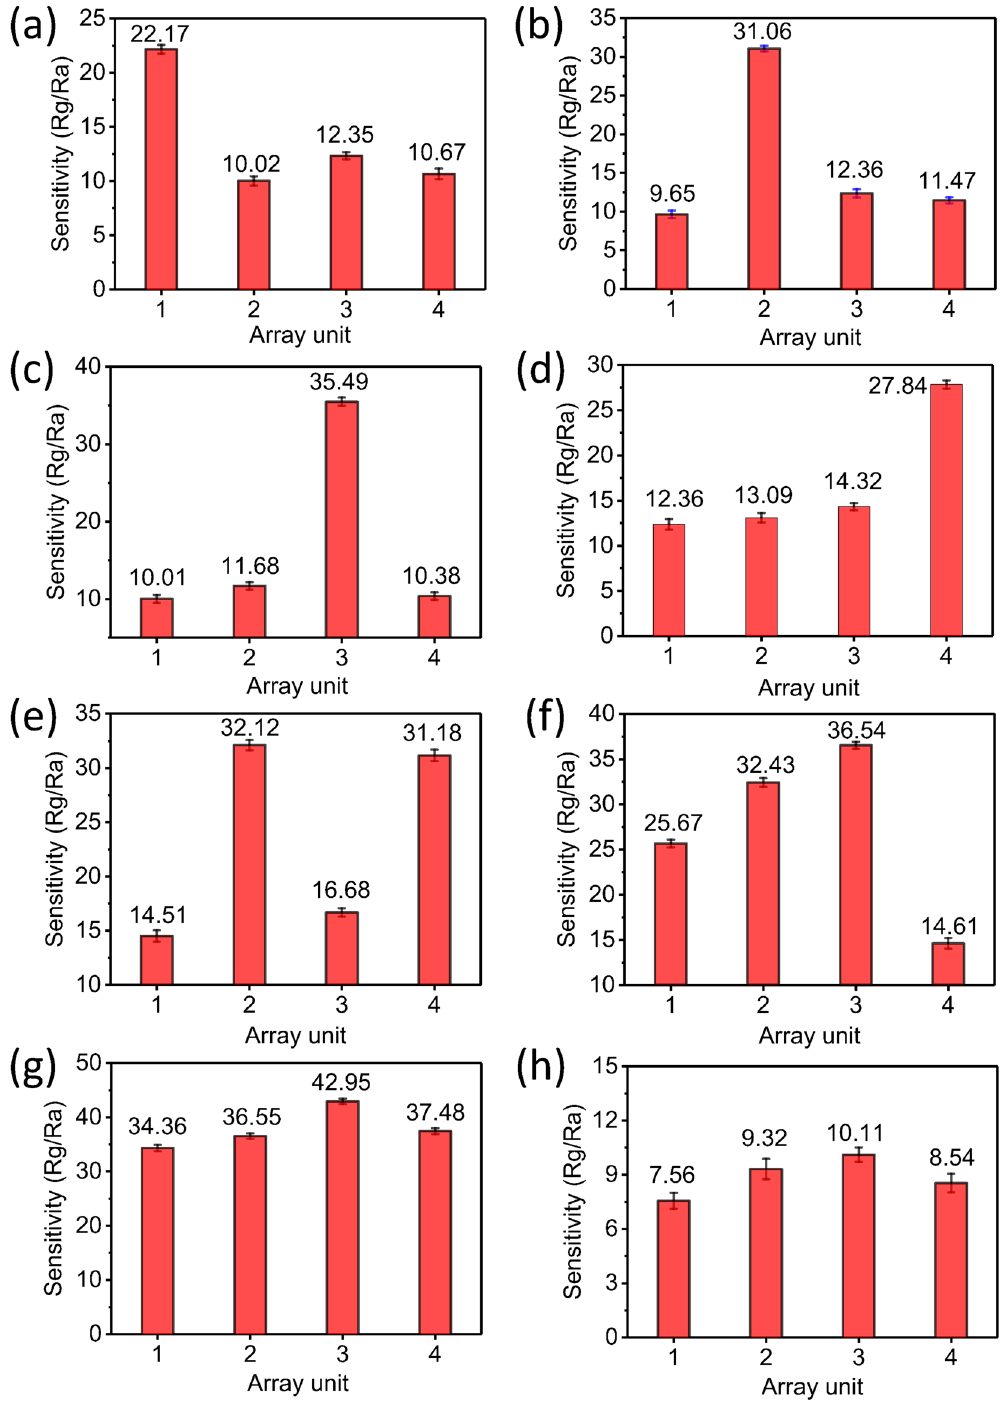
Figure 3. The sensitivity of the array to the target analytes and interferents (ethanol, gasoline, toluene and ammonia). ( a ) Acetone + interferents: unit 1 responded markedly; ( b ) benzene + interferents: unit 2 responded markedly; ( c ) methanol + interferents: unit 3 responded markedly; ( d ) formaldehyde + interferents: unit 4 responded markedly; ( e ) benzene + formaldehyde + interferents: units 2 and 4 responded simultaneously; ( f ) acetone + benzene + methanol + interferents: units 1, 2 and 3 responded simultaneously; ( g ) all eight analytes: all of the units responded simultaneously; and ( h ) interferents: no notable response was